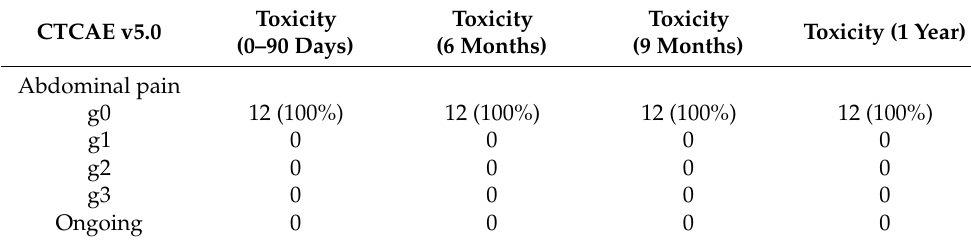
Table 6. Assessment of